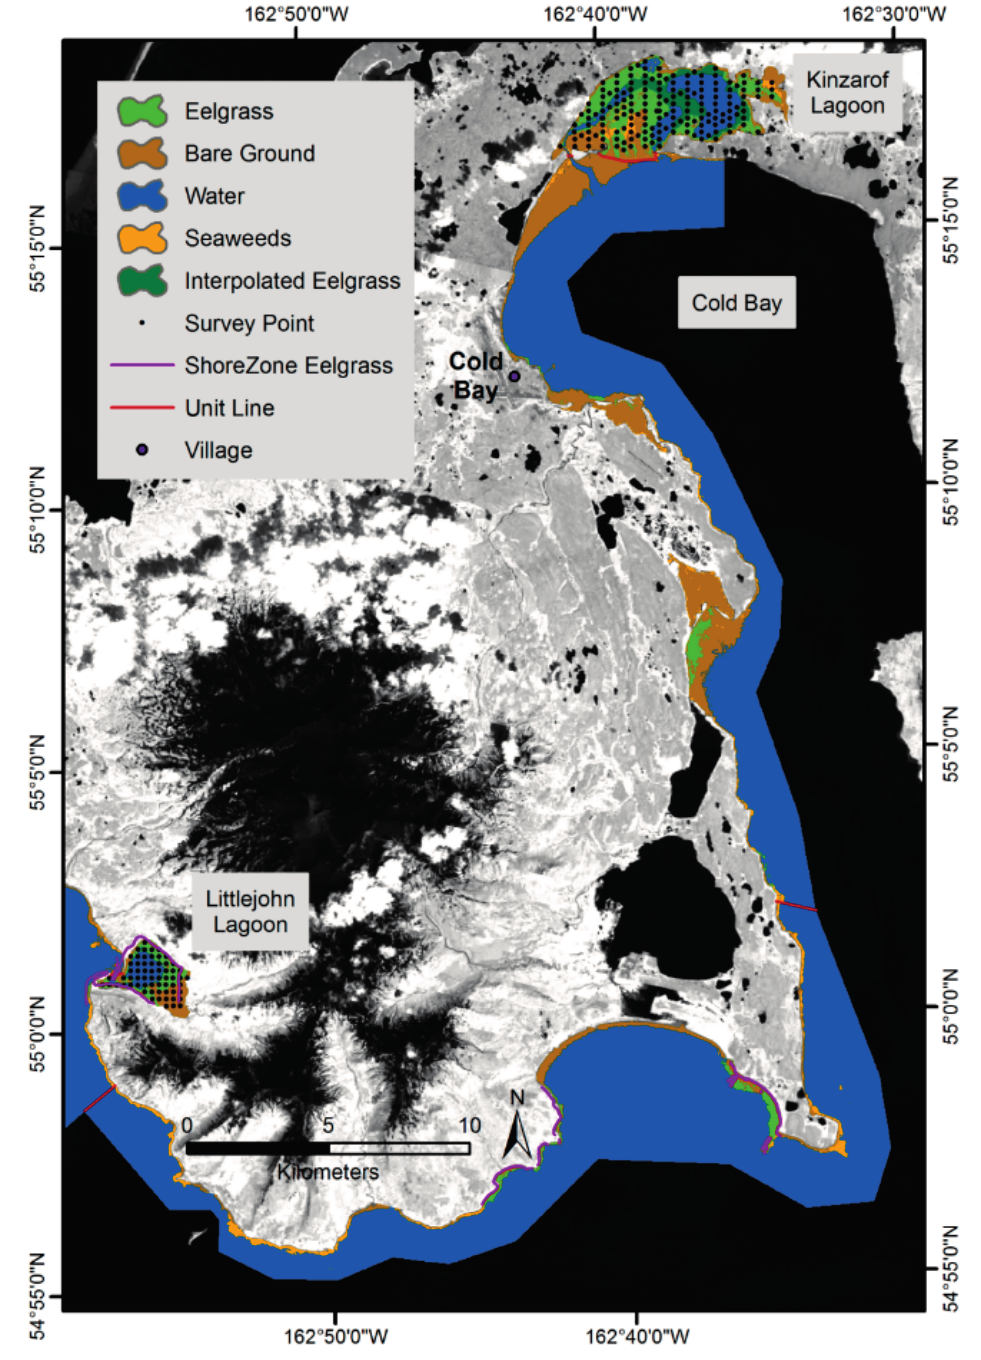
Figure 6. Distribution of eelgrass and other habitats as derived from Landsat imagery (displayed as a black/grayscale backdrop) for coastal areas between Morzhovoi and Cold bays where ShoreZone data were used to differentiate between eelgrass and other